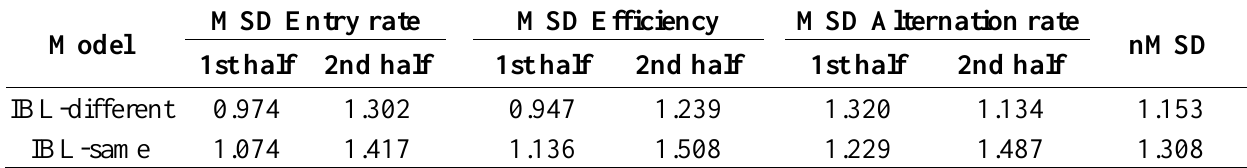
Table 1. Summary of fit results in the Estimation